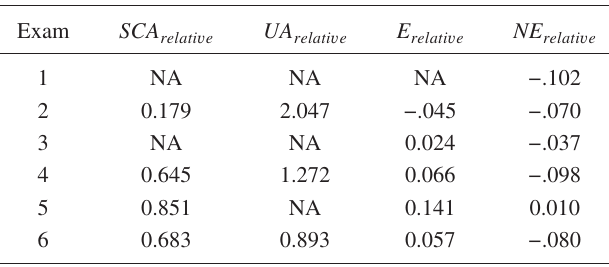
TABLE IV. Measures of relative overall class performance for exams 1 through 6. The definitions of each measure are described in the